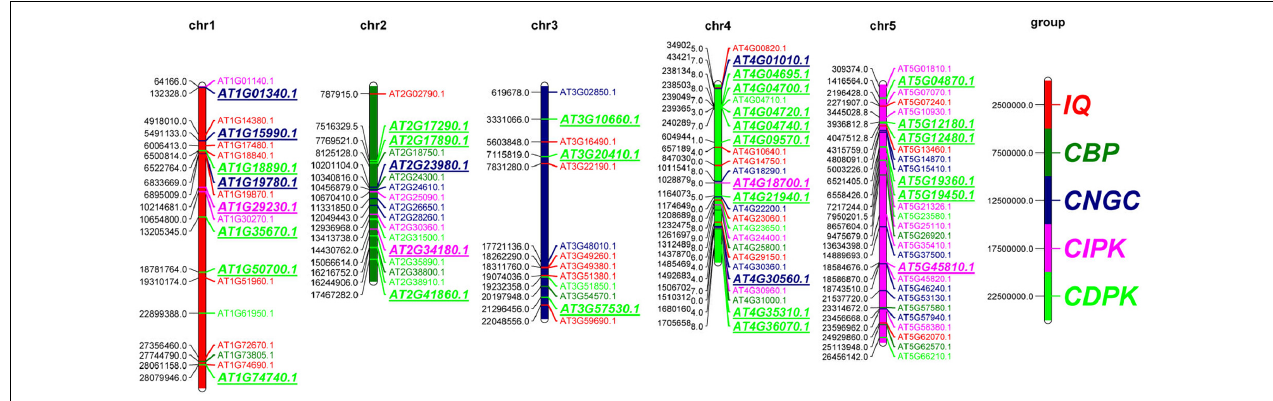
FIGURE 1 | Chromosomal location of the 102 genes in calcium-related gene families in A. thaliana . The distribution of the 102 genes on the five chromosomes (chr1-chr5) is presented. Different gene families are marked by different colors. The duplications were marked in